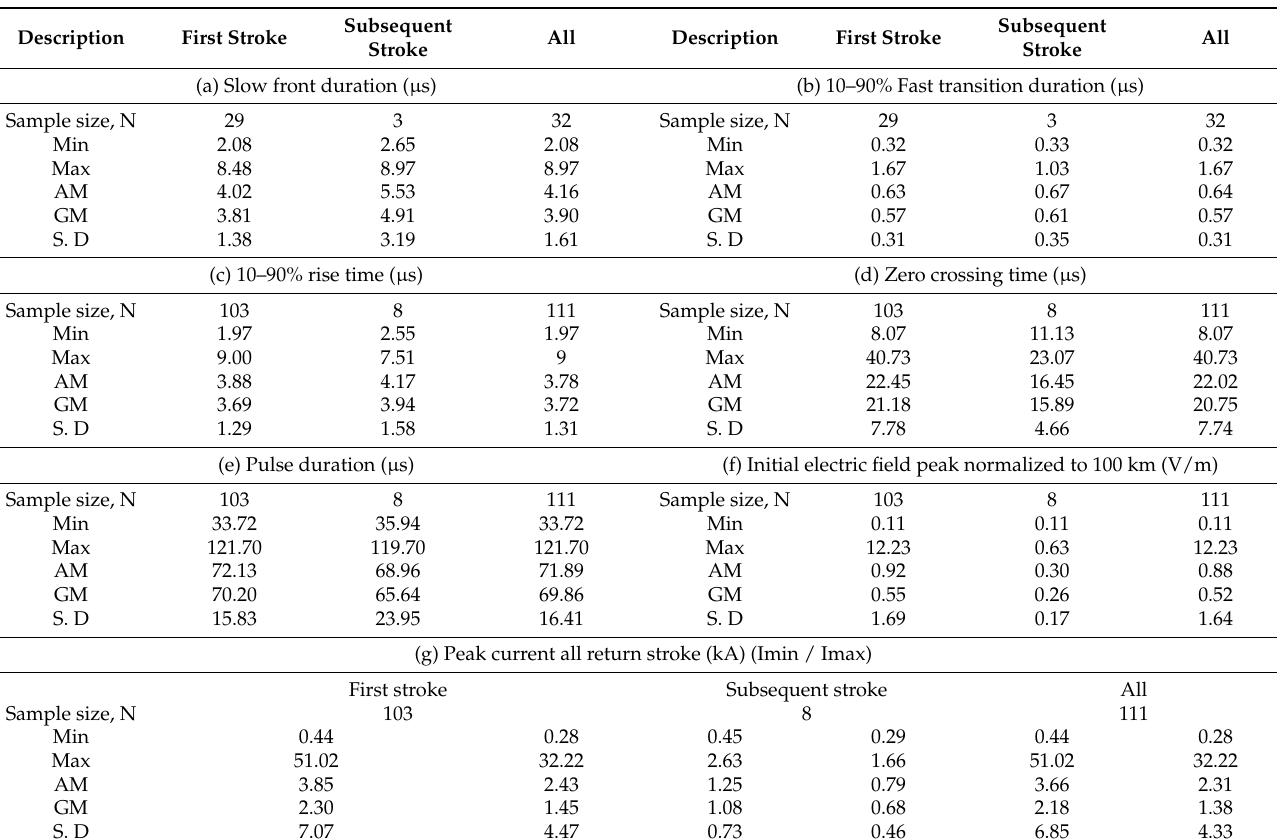
Table A2. Comparison of − CG flashes parameters for first, subsequent and all return strokes in Antarctica.